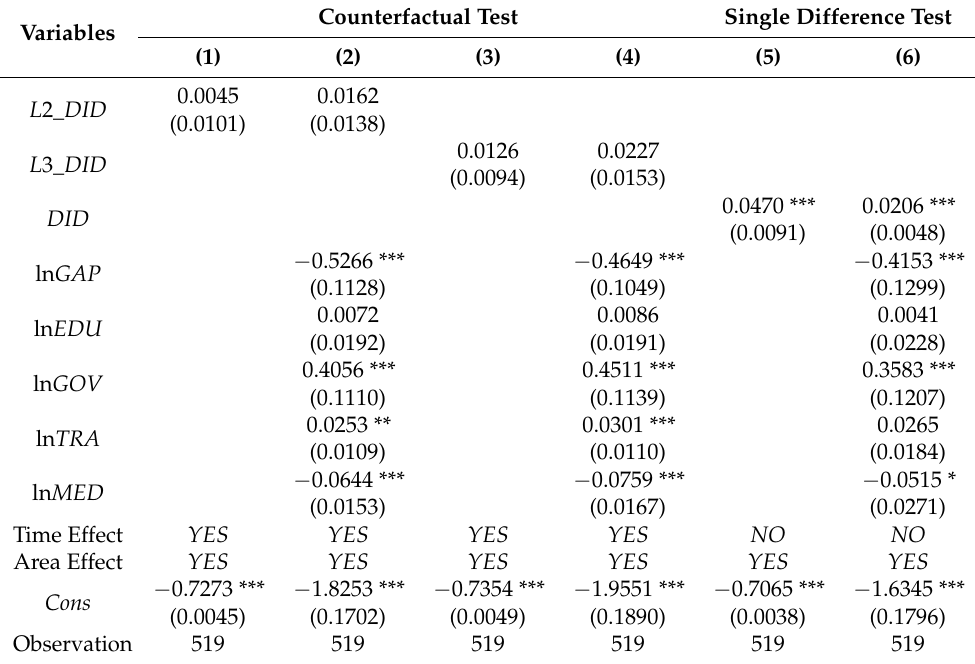
Table 5. Results of robustness